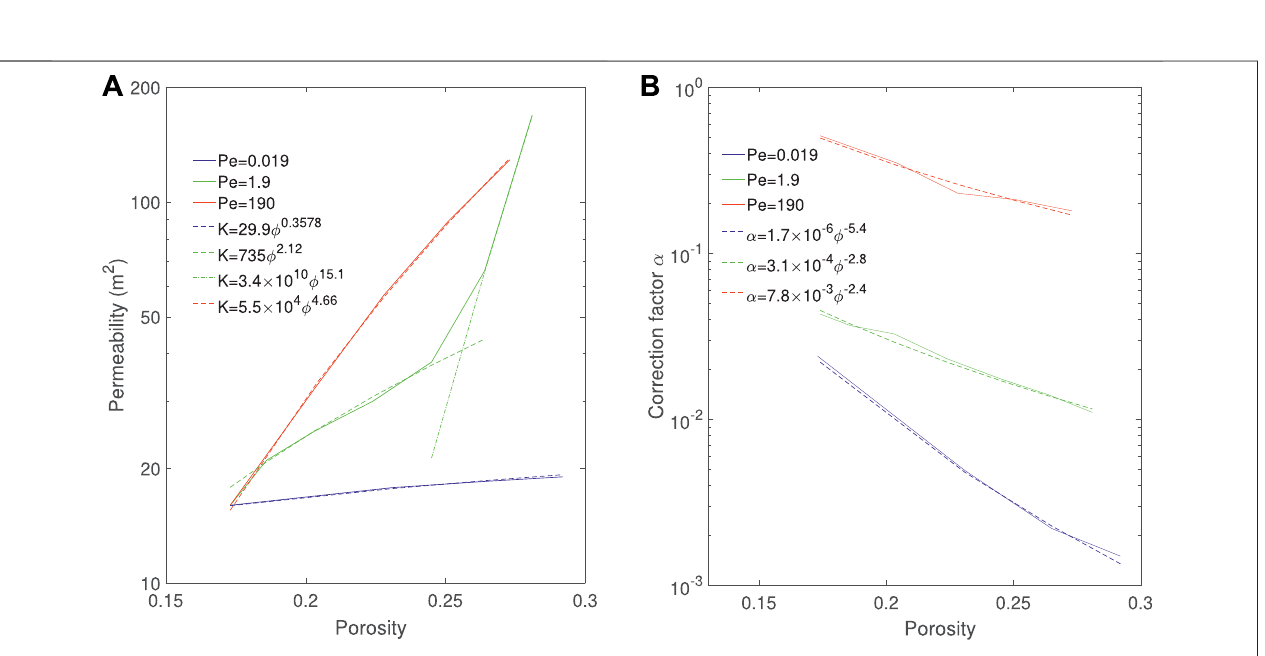
Frontiers in Earth Science |